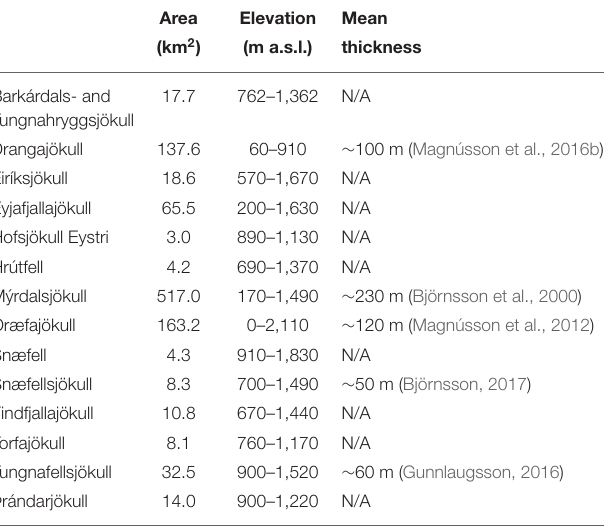
TABLE 1 | Overview of 14 glaciers and ice